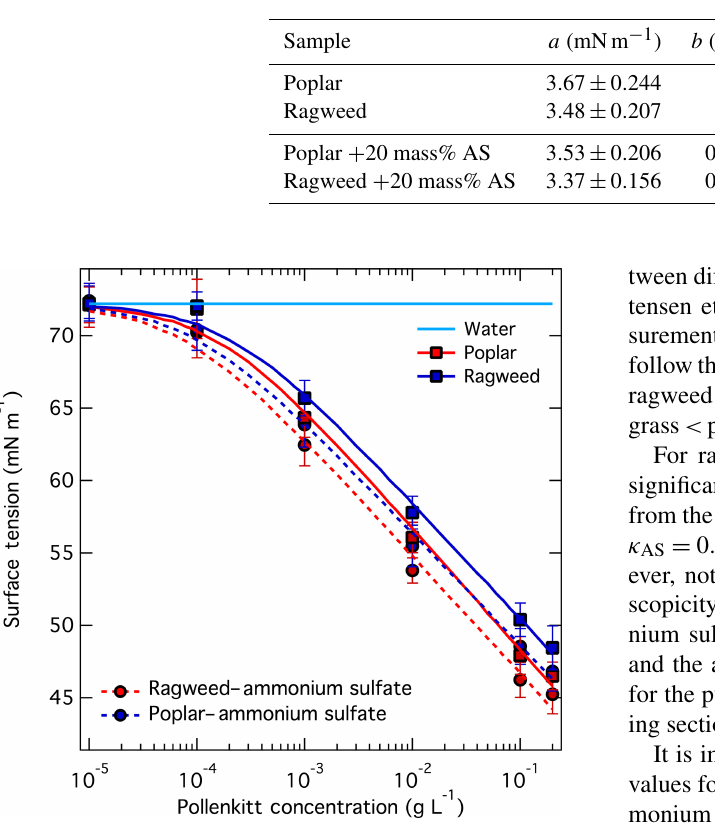
Table 3. Pollenkitt surface activity: Szyskowski fitting parameters according to Eq. (3) for bulk aqueous solutions of ragweed and poplar pollenkitts and their mixtures with ammonium sulfate.